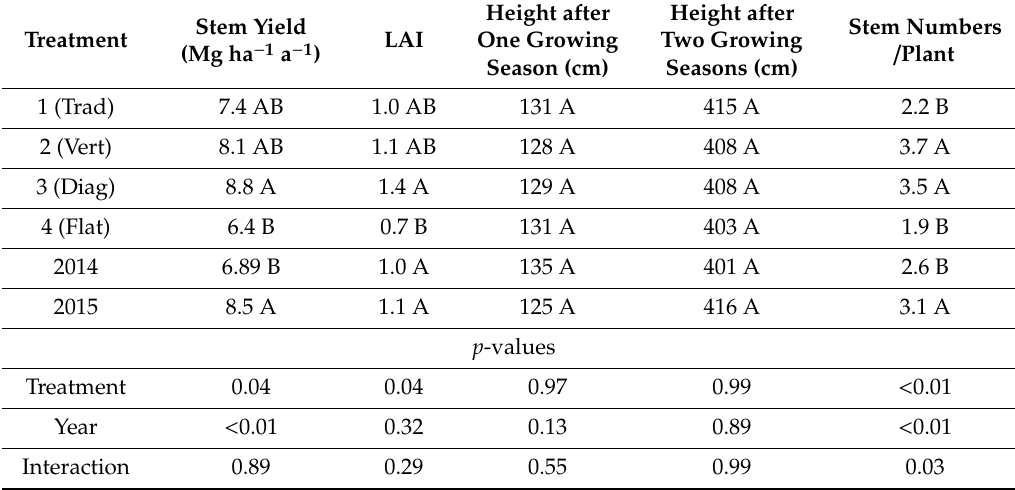
Table 5. Stem yield (represented as dry matter tonnes per hectare measured after two growing seasons), Leaf Area Index (LAI), stem height (height of the tallest stem in each plant) and stem numbers for two trials planted in 2014 and in